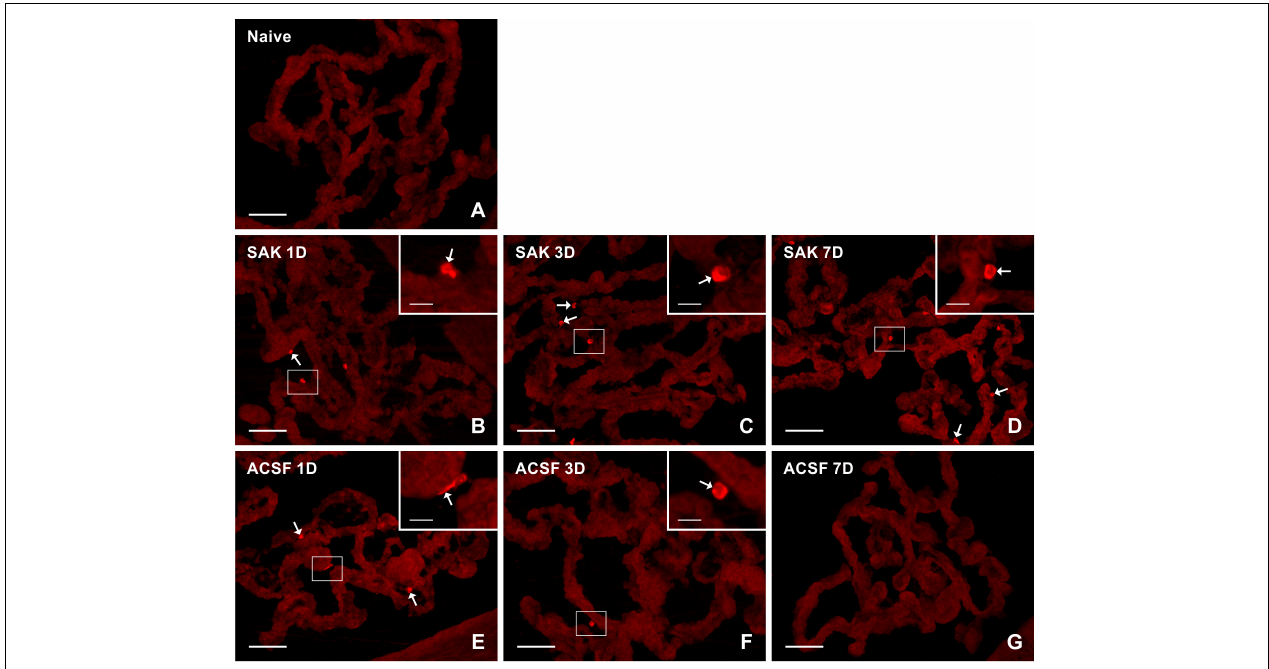
FIGURE 4 | Representative pictures of cryostat sections through the CP showing immunostaining with CD206 antibody from naïve (A) , SAH (B–D), and ACSF (E–G) rats at 1, 3, and 7 days (1D, 3D, and 7D) after operation. Increased numbers of CD206+ cells were found 1, 3, and 7 days following induction of SAH. ACSF application led to an increase in the number of CD206+ cells 1 and 3 days following injection. Arrows indicate CD206+ cells in epiplexus position of the CP. Insets show a higher magnification of regions marked by the boxes. Scale bars = 80 µ m (main image); 10 µ m